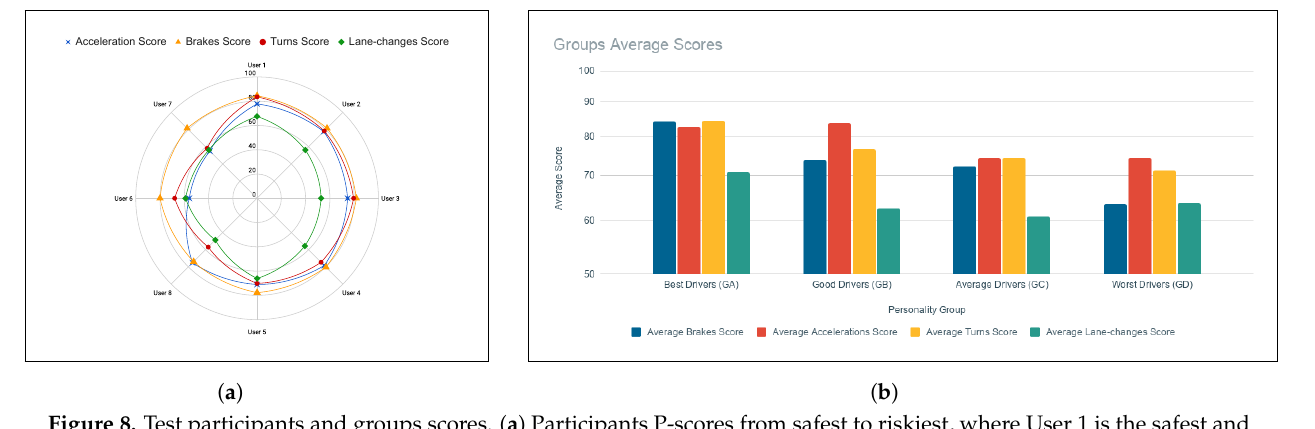
Figure 8. Test participants and groups scores. ( a ) Participants P-scores from safest to riskiest, where User 1 is the safest and User 7 is the riskiest driver. ( b ) Personality groups average scores: extracted from the Personality Model Groups. Details about the personality group model are in Section 3.4.